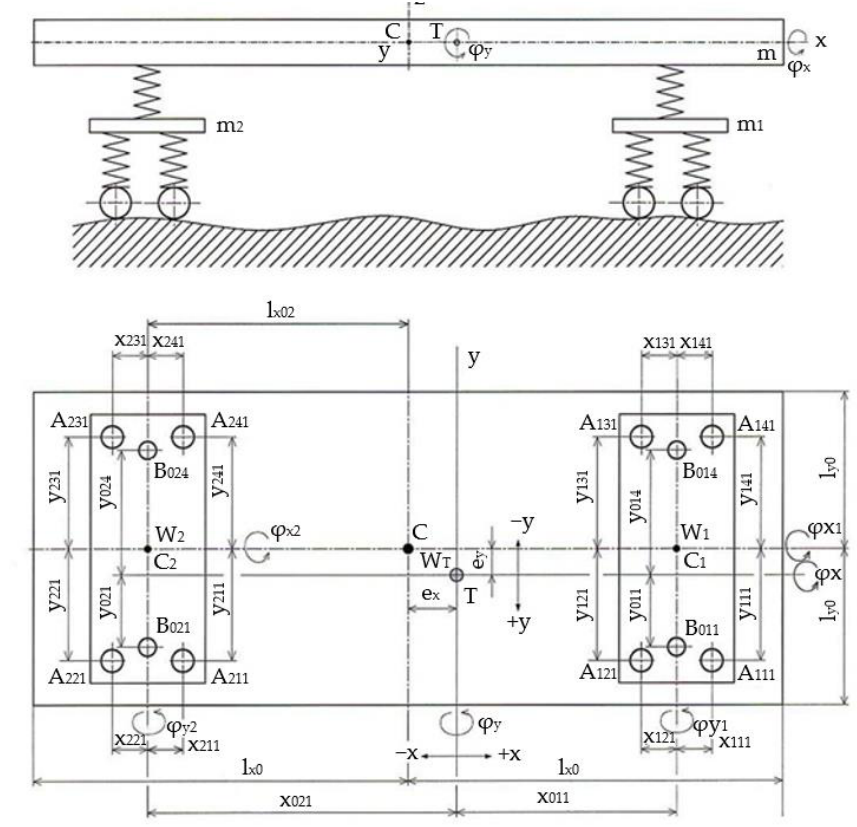
Figure 2. The scheme of the model.